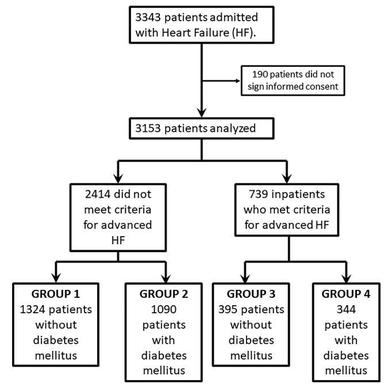
Patient inclusion flowchart.